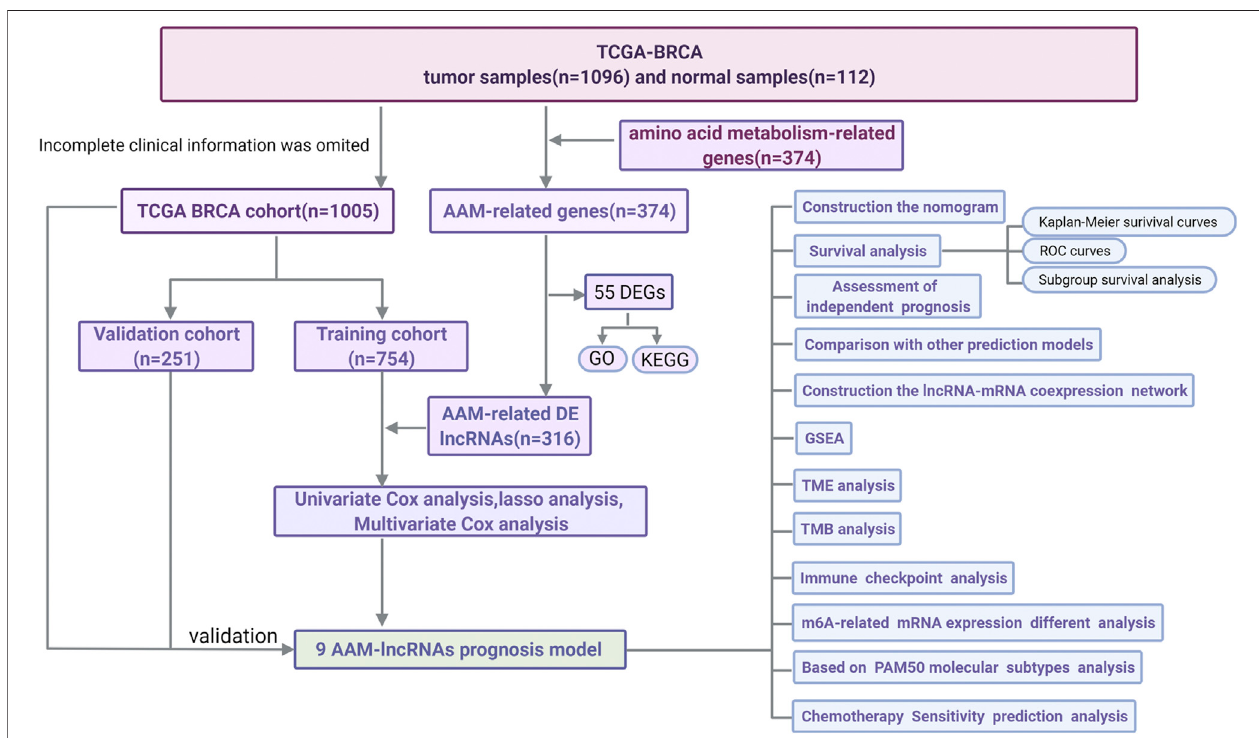
FIGURE 1 | A fl ow chart of the data analysis and process.